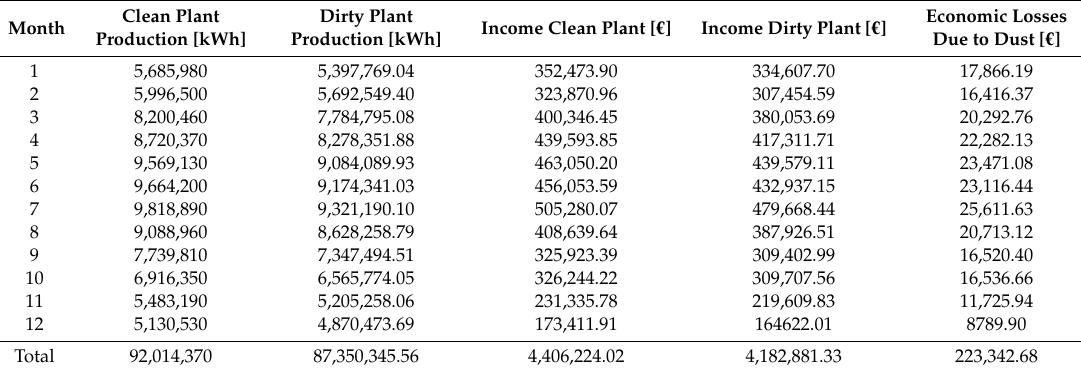
Table 9. Revenues from the 50 MWp plant when clean and dirty.